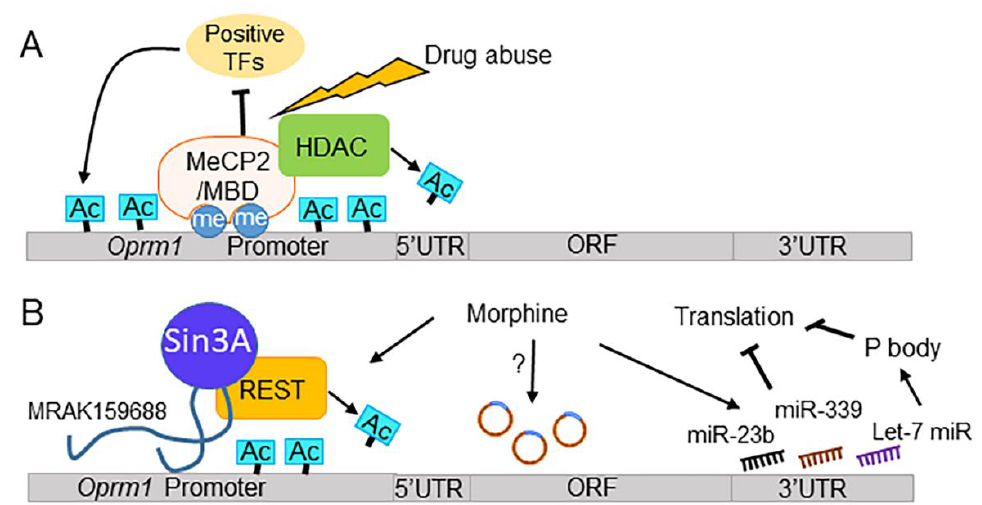
Figure 3. A hypothetical model of epigenetic suppression of Oprm1 by drugs of abuse. ( A ) Potential cross-regulation between DNA methylation and histone modifications on Oprm1 . The drugs of abuse enhance MeCP2 and other methyl-CpG-binding domain (MBD) proteins, which recognize DNA methylation and mark the promoter of Oprm1 . This results in the recruitment of HDAC1, which removes the acetyl groups from the locus. The process suppresses the promoter from transcriptional activities; thus, Oprm1 expression level is dampened. (B ) ncRNA mediated suppression of Oprm1 . Morphine treatment enhances the levels of MRAK159688 (lncRNA), miR-23b, miR-339 and Let- 7 family miRNAs [152,165]. All these ncRNAs can recruit transcriptional co-repressors to suppress the transcription of Oprm1. Alternatively, they can limit Oprm1 mRNA translation by directly binding to its 3 (cid:48) UTR or sequestering the mRNA at the processing body